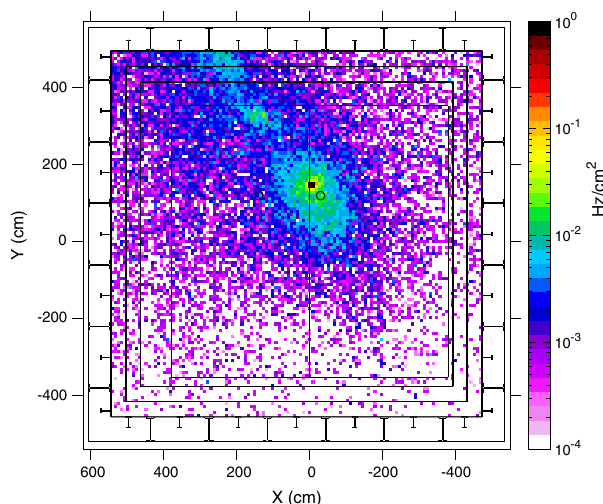
FIG. 9. All charged particles fluence impinging on the front face of the NP-04 detector. The the beam spot is shown around (0, 150), while the small hole next to it represents the entrance of the beam in the TPC active volume. A halo produced by a tail of high-energy particles, deflected in the higher-part of the cryostat can be also seen.